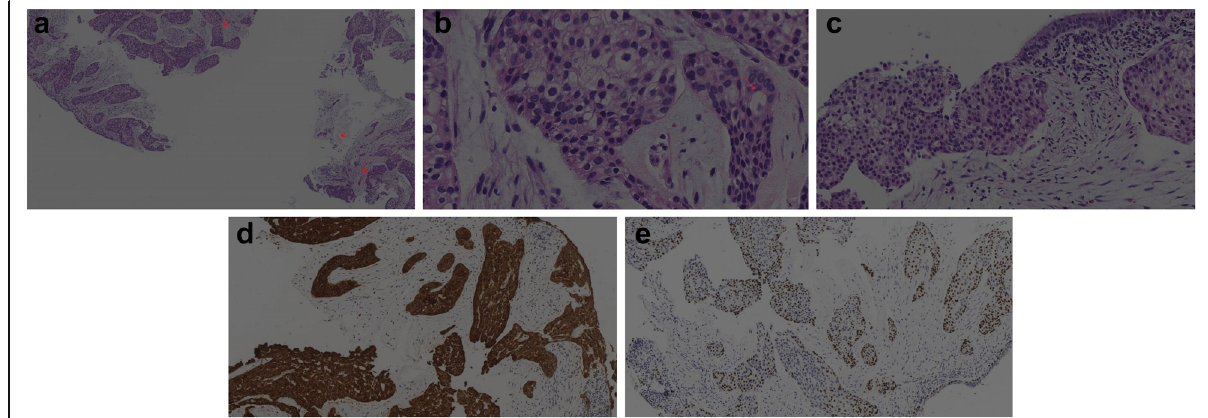
Fig. 2 A The tumor cells arranged in irregular nests, cords, trabeculae, and tubular shapes with loose mucinous stroma and focal stroma hyalinized (red arrow) (HEx 40). B Atypical small-to-medium-sized epithelioid cells with light eosinophilic to clear cytoplasm lacking significant pleomorphism and mitotic activity arranged in irregular nests, cords, trabeculae, and tubular patterns (red arrow) with a loose myxoid stroma (C) (HEx 200). Focally, the tumor cells appeared to be connected to the basal layer of the bronchial epithelium. D Immunohistochemistry revealed that the tumor cells were positive for CK7. E Immunohistochemistry revealed that most of the tumor cells were positive for